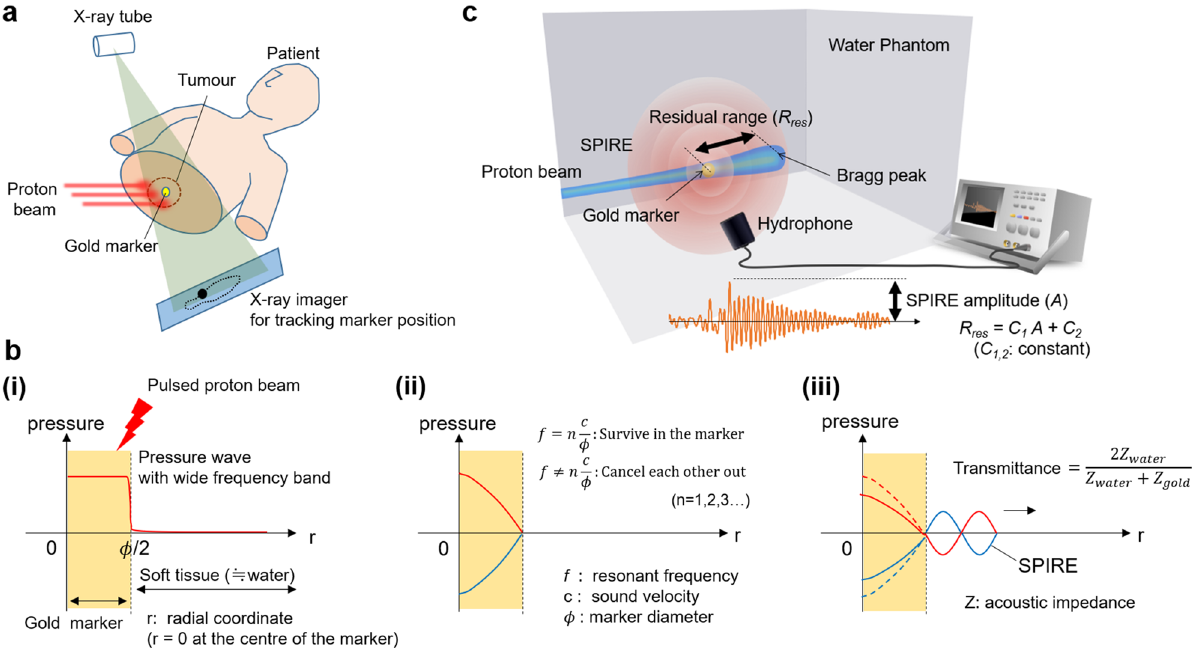
Figure 1. Proton beam range detection using SPIRE measurement. ( a ) Schematic representation of patient positioning during proton beam delivery using a gold fiducial marker. Spherical gold markers of 2 mm diameter are inserted in or near to the tumour and constantly monitored by X-ray fluoroscopy during beam delivery. If two sets of fluoroscopies are used, the marker’s three-dimensional coordinates can be obtained. ( b )